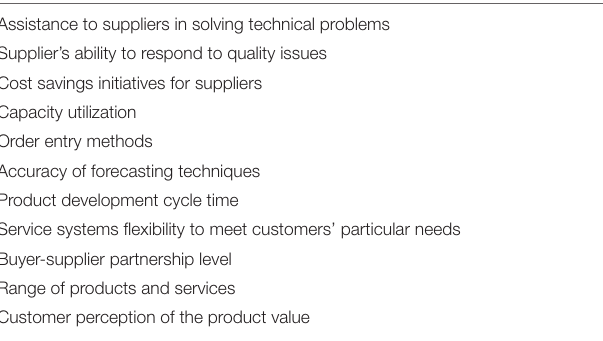
TABLE 6 | Performance metrics for the innovation/learning perspective.